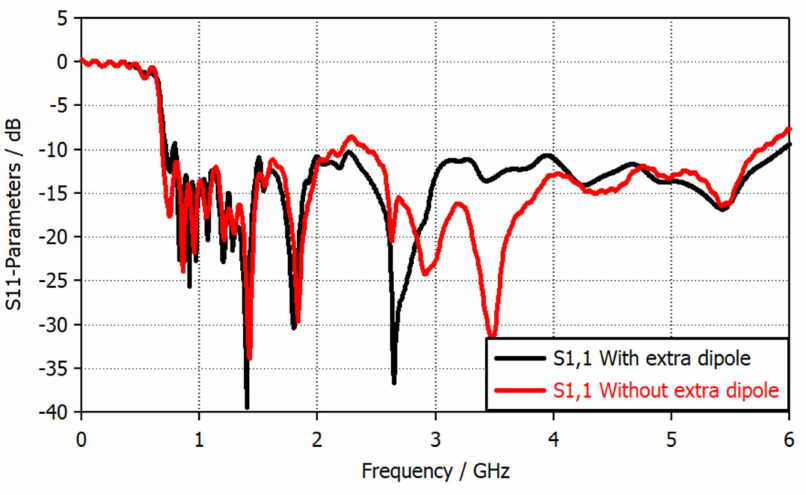
Figure 8. S11-parameter versus frequency with/without extra